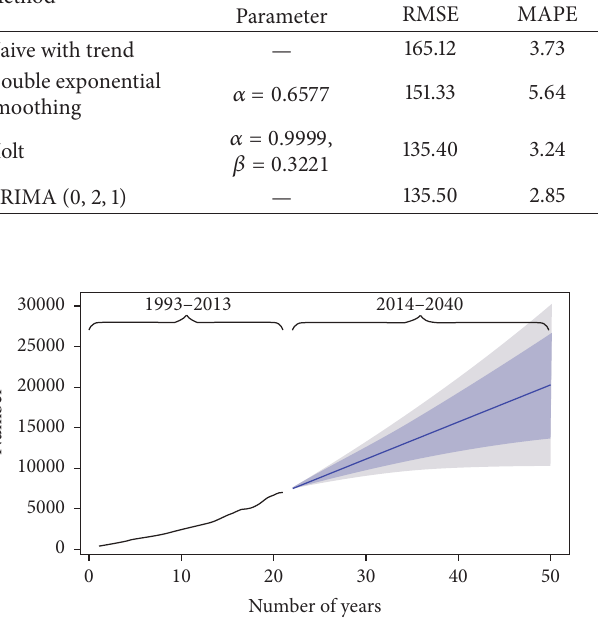
Figure 1: Trend and forecast values for incidence of ESRD patients (ARIMA [ 0 , 2 , 1 ]).